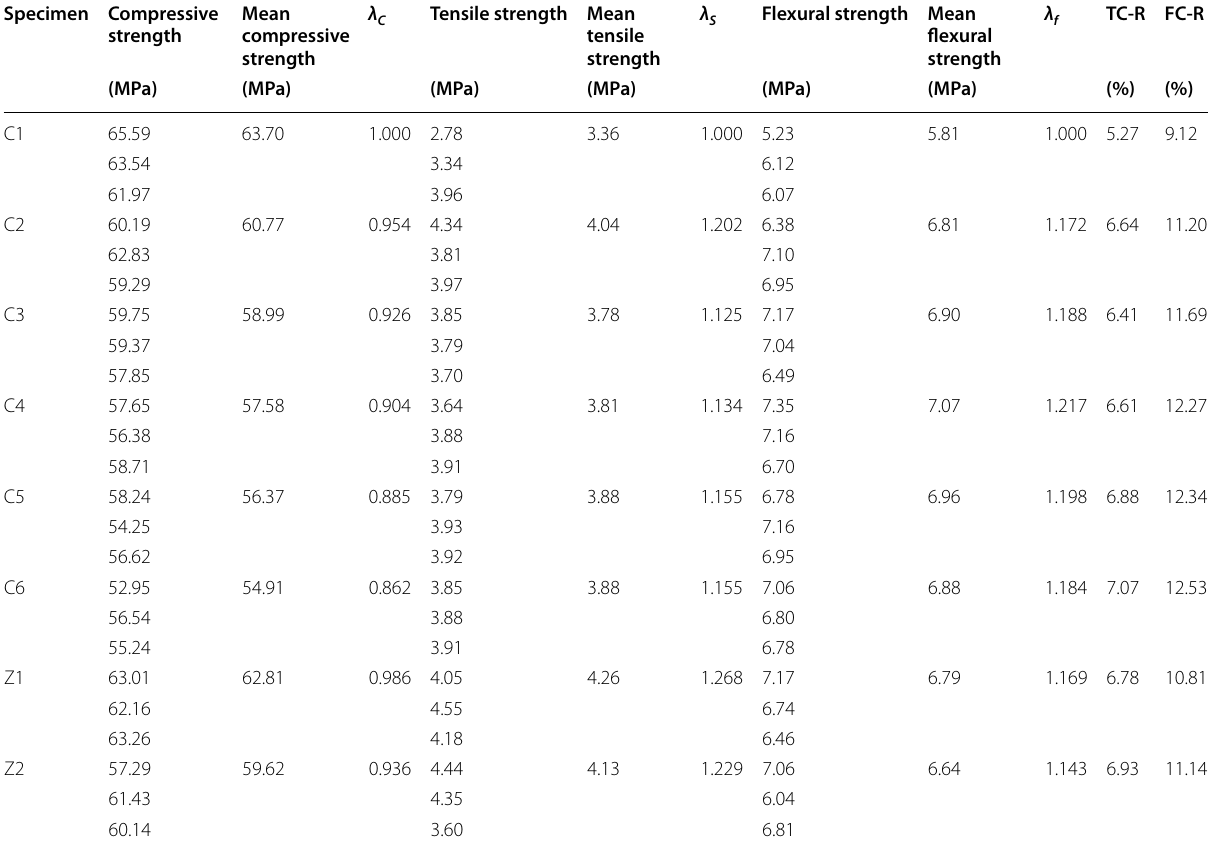
Table 4 Experimental